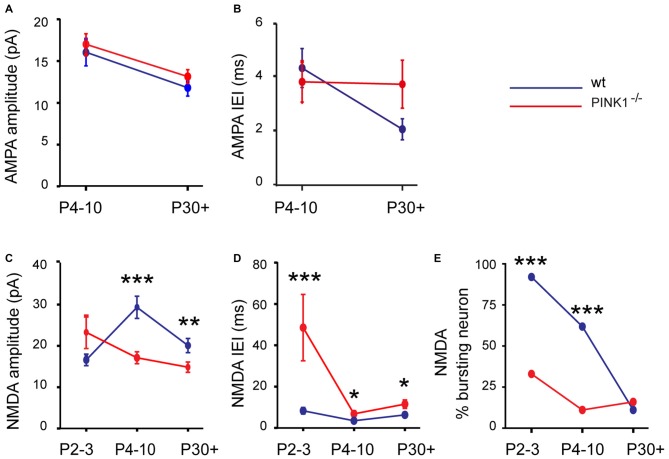
Developmental profile in pink1−/− (red) and wt (blue) SNc DA neurons of the amplitude (A) and IEIs (B) of AMPA sEPSCs; of the amplitude (C) and IEIs (D) of NMDA sEPSCs; of the percentage of neurons with bursts of NMDA sEPSCs (E).